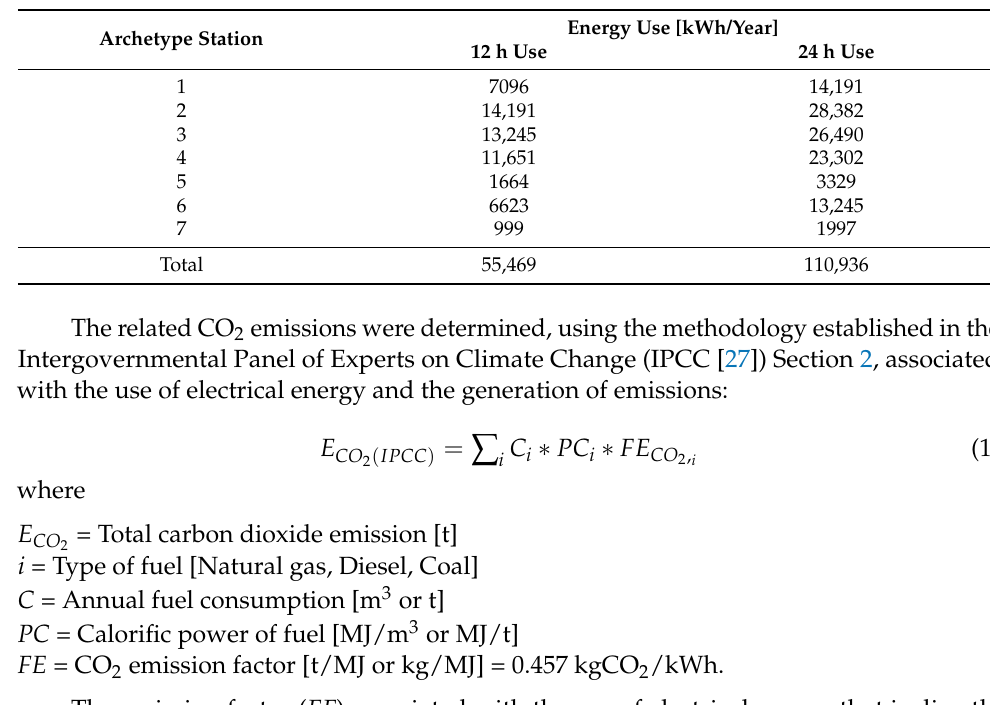
Table 3. Energy demand scenarios for the campus bus stations.